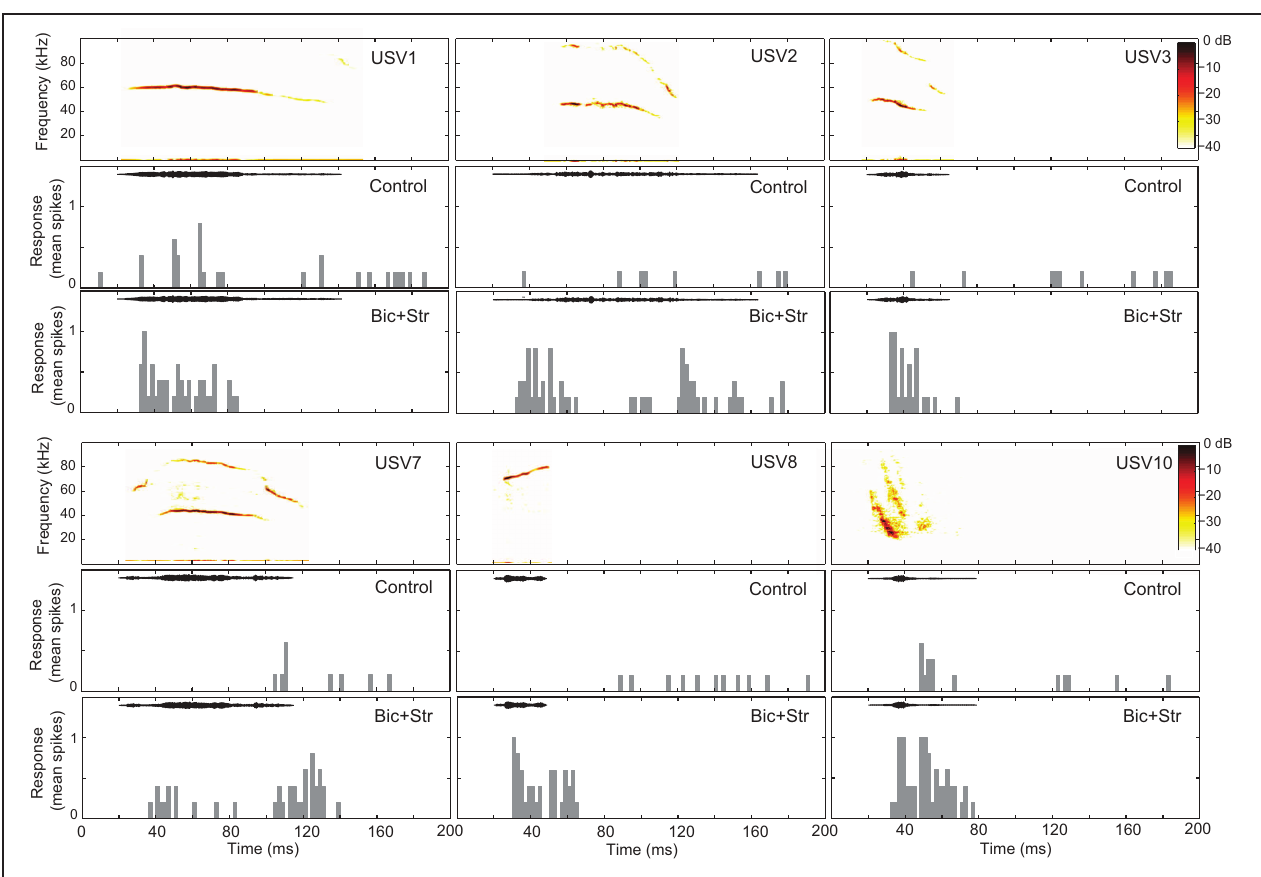
FIGURE 3 | Blocking GABA A R and GlyR decreases neuronal selectivity to vocalizations in the IC. The responses of one single unit to six vocalizations before (control) and after (Bic + Str) blocking GABA A R and GlyR. Responses